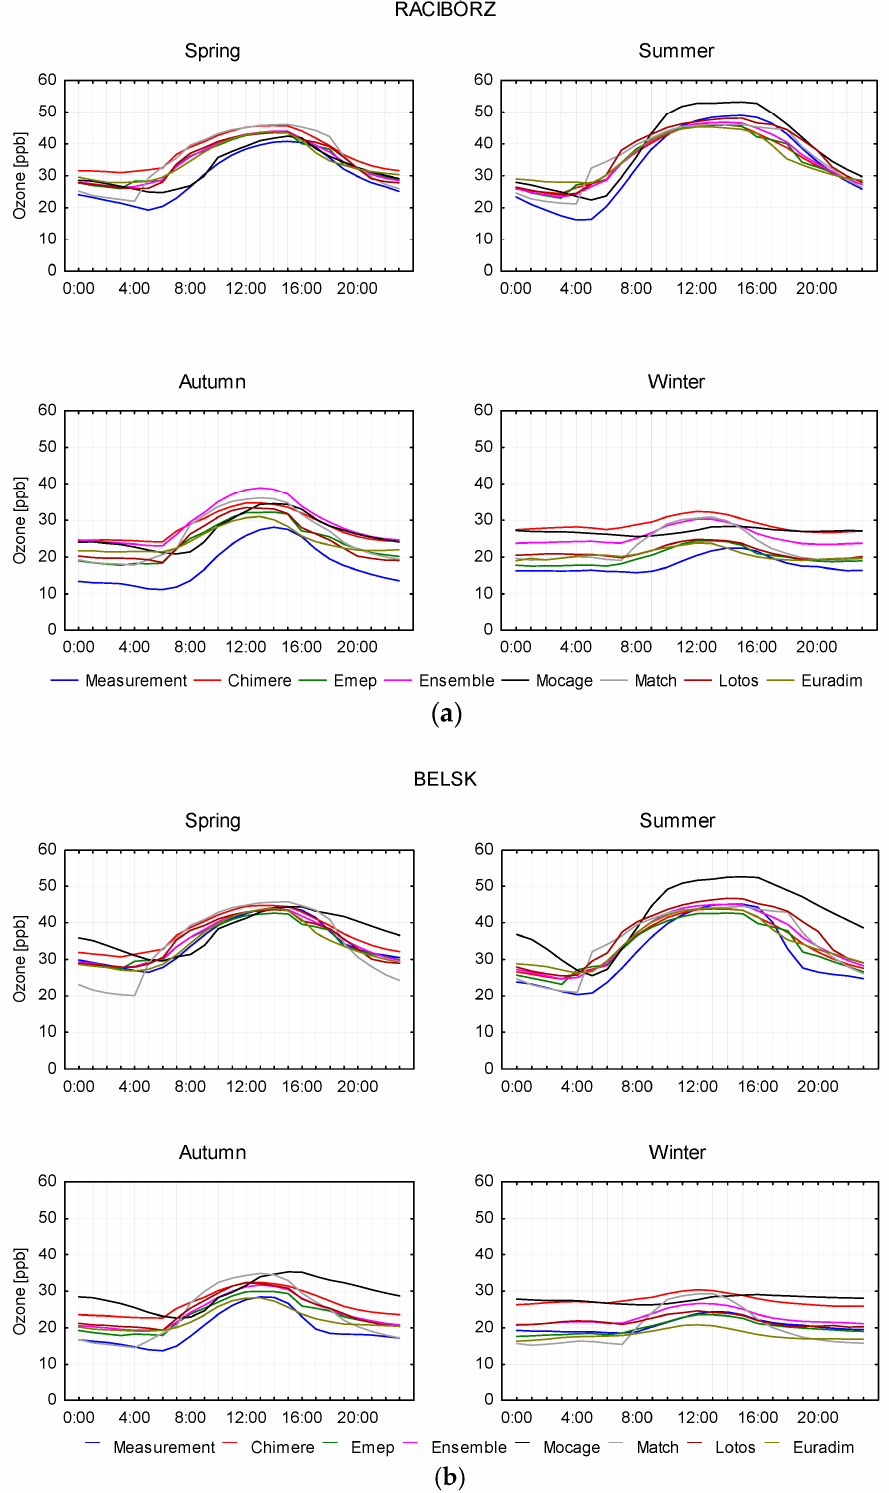
Figure 6. Time series of diurnal variation of surface O 3 concentration for each season at Racibórz ( a ) and Belsk ( b ) station for the period 2018–2021. Colors of lines: blue-measurement, red- Chimere , dark green- Emep , pink- Ensemble , black- Mocage , light grey- Match , brown- Lotos , light green- Euradim .